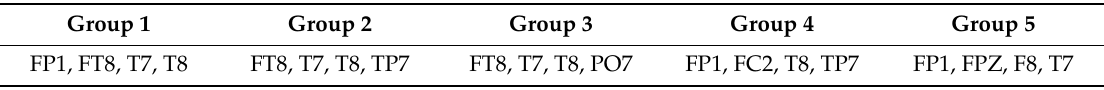
Table 1. Groups of channels used in the classification experiments.